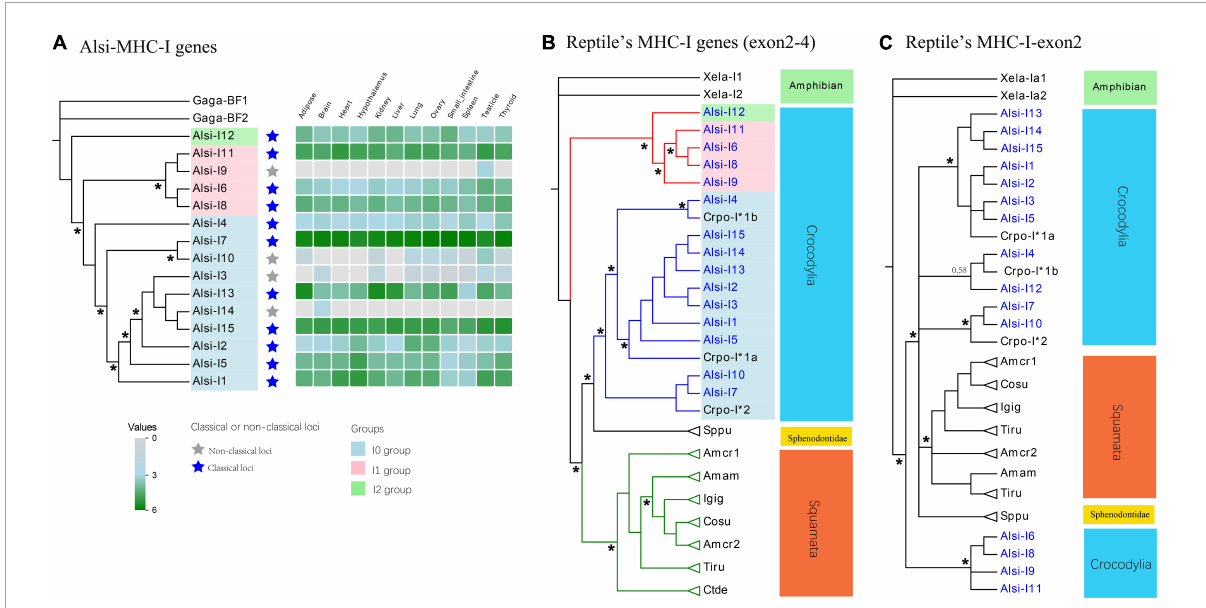
FIGURE5 Phylogenetic evolution of MHC-I genes in (A) Chinese Alligator, (B) in reptiles using the main CDS (exon 2 to exon 4), and (C) in reptiles using the antigen-presenting exon 2. The expression data in panel (A) were calculated using the log10 of TPM values, and all the values under one were treated as zero. The genes extracted in our study are labeled with blue names in panels (B,C) . Stars on phylogenetic trees suggest bootstrap values > 0.7, and some vital bootstrap values less than 0.7 are also listed with numbers. All the corresponding sequences are listed in Supplementary Table 2 . Gaga, Gallus gallus ; Xela, Xenopus laevis ; Amcr, Amblyrhynchus cristatus ; Sppu, Sphenodon punctatus ; Crpo, Crocodylus porosus ; Amam, Ameiva ameiva ; Cosu, Conolophus subcristatus ; Ctde, Ctenophorus decresii ; Igig, Iguana iguana ; Tiru, Tiliqua rugosa